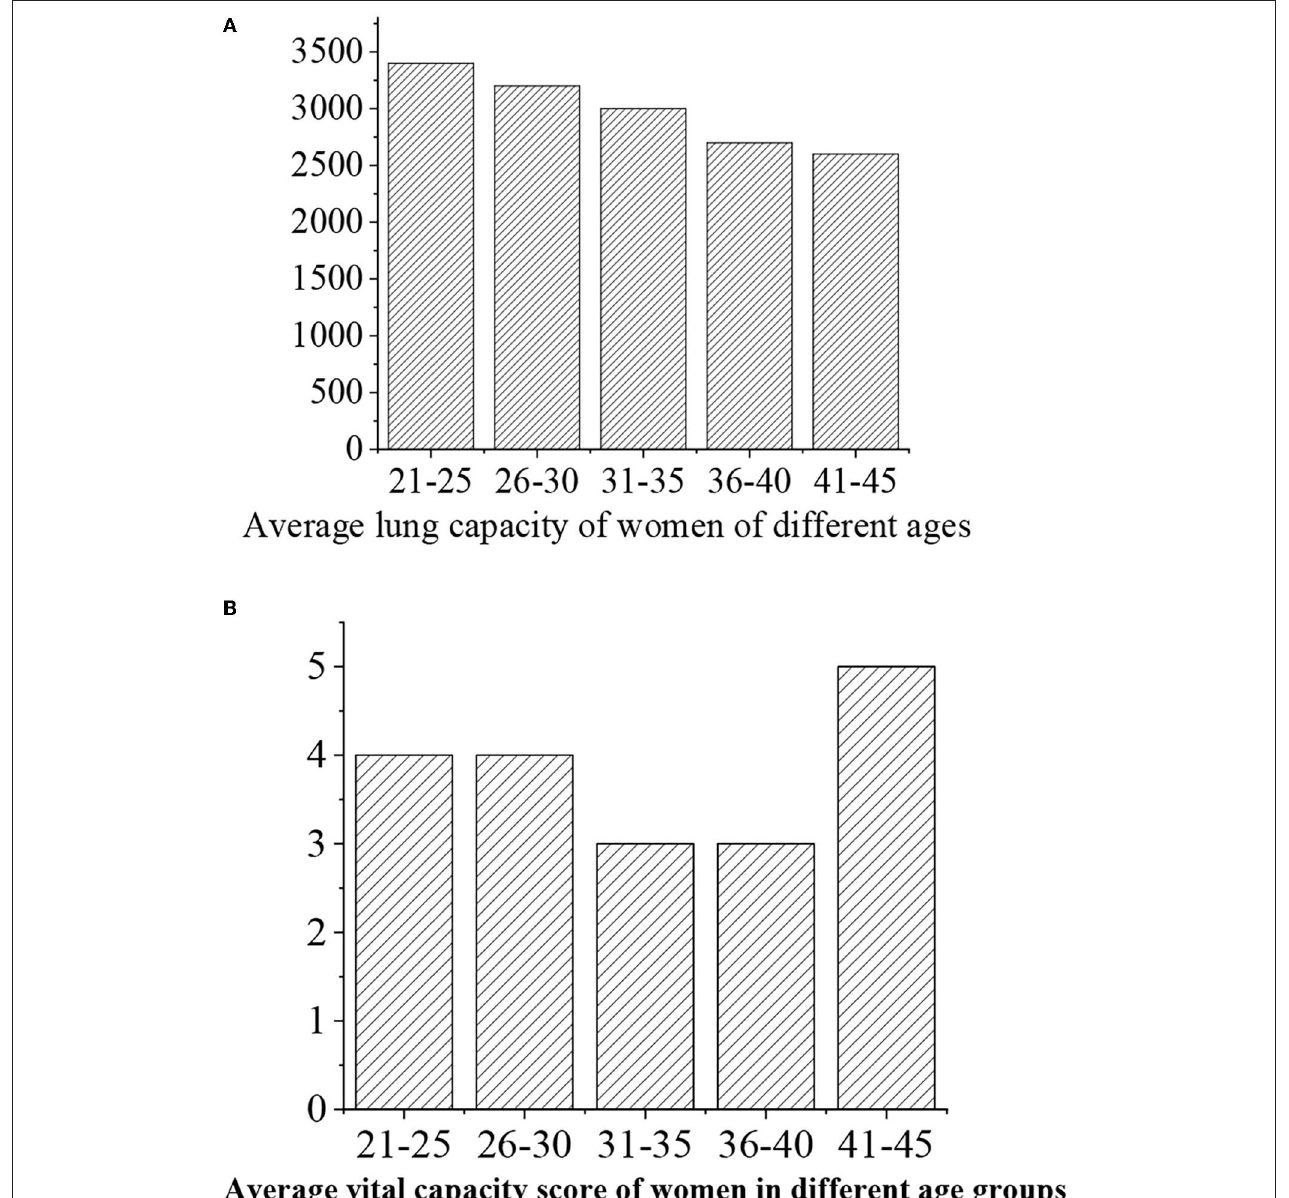
FIGURE 13 | (A) Statistical vital capacity for women of different ages. (B) Vital capacity score.